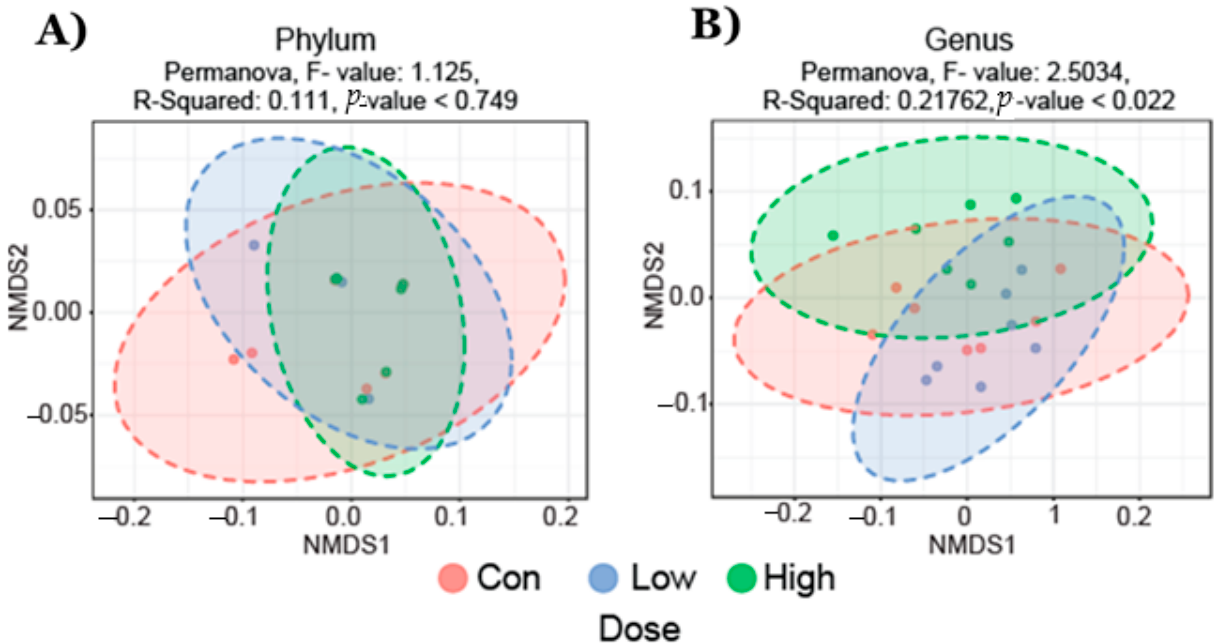
Figure 2. Non-metric multidimensional scaling ( NMDS) plot of fecal bacterial community structures in animals fed with control diet ( n = 7), TRP-deficient diet ( n = 7), and TRP-rich diet ( n = 7). Data showed no significant differences at ( A ) the phylum levels but formed distinct clusters at ( B ) the genus level specific to a TRP-deficient diet; (Permanova, F-value; 2.5034, R-squared; 0.21762, p -value < 0.022).